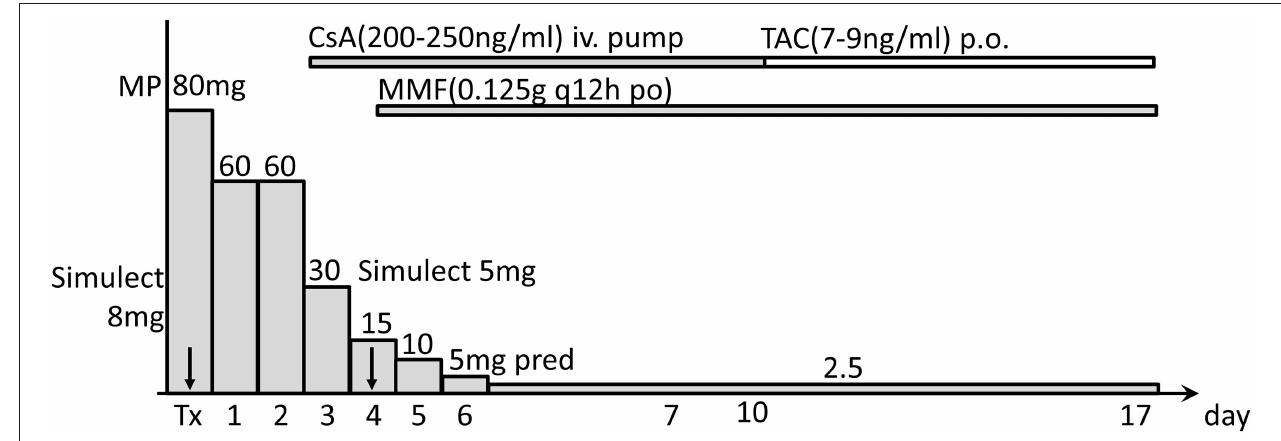
FIGURE 3 | Immunosuppressive regimen used after transplantation. Post-operative immunosuppression included Simulect basiliximab (induction), cyclosporine (CsA), tacrolimus (TAC), mycophenolate mofetil (MMF), methylprednisolone (MP), and prednisone (pred). Tx, transplantation day 0; arrows indicate days of using Simulect.